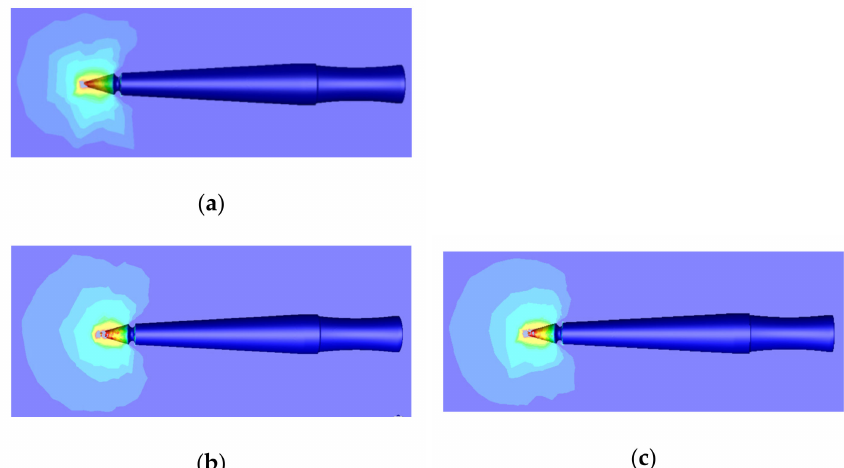
Figure 8. Pressure distribution of di ff erent grid numbers: ( a ) Thin; ( b ) Unrefined; ( c ) Refined.